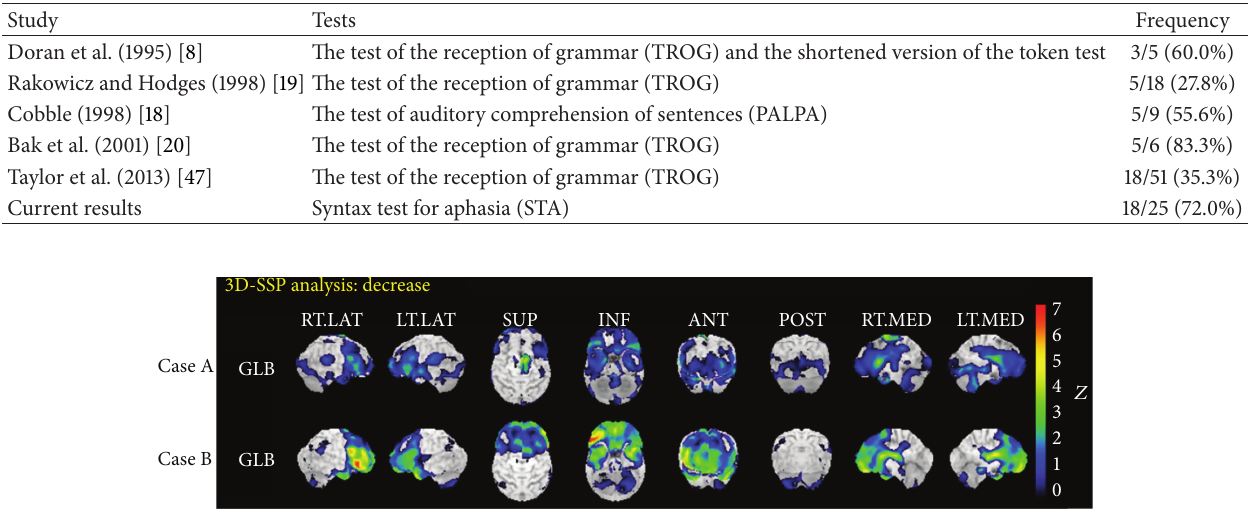
Figure 2: 3D-SSP Analysis. Case A. IMP-SPECT images revealed mildly reduced r-CBF in the bilateral frontal lobes of patient 7, who was within normal limits at all of three tests. Case B. IMP-SPECT images revealed moderately reduced r-CBF in the bilateral frontotemporal lobes of patient 22, who failed all three